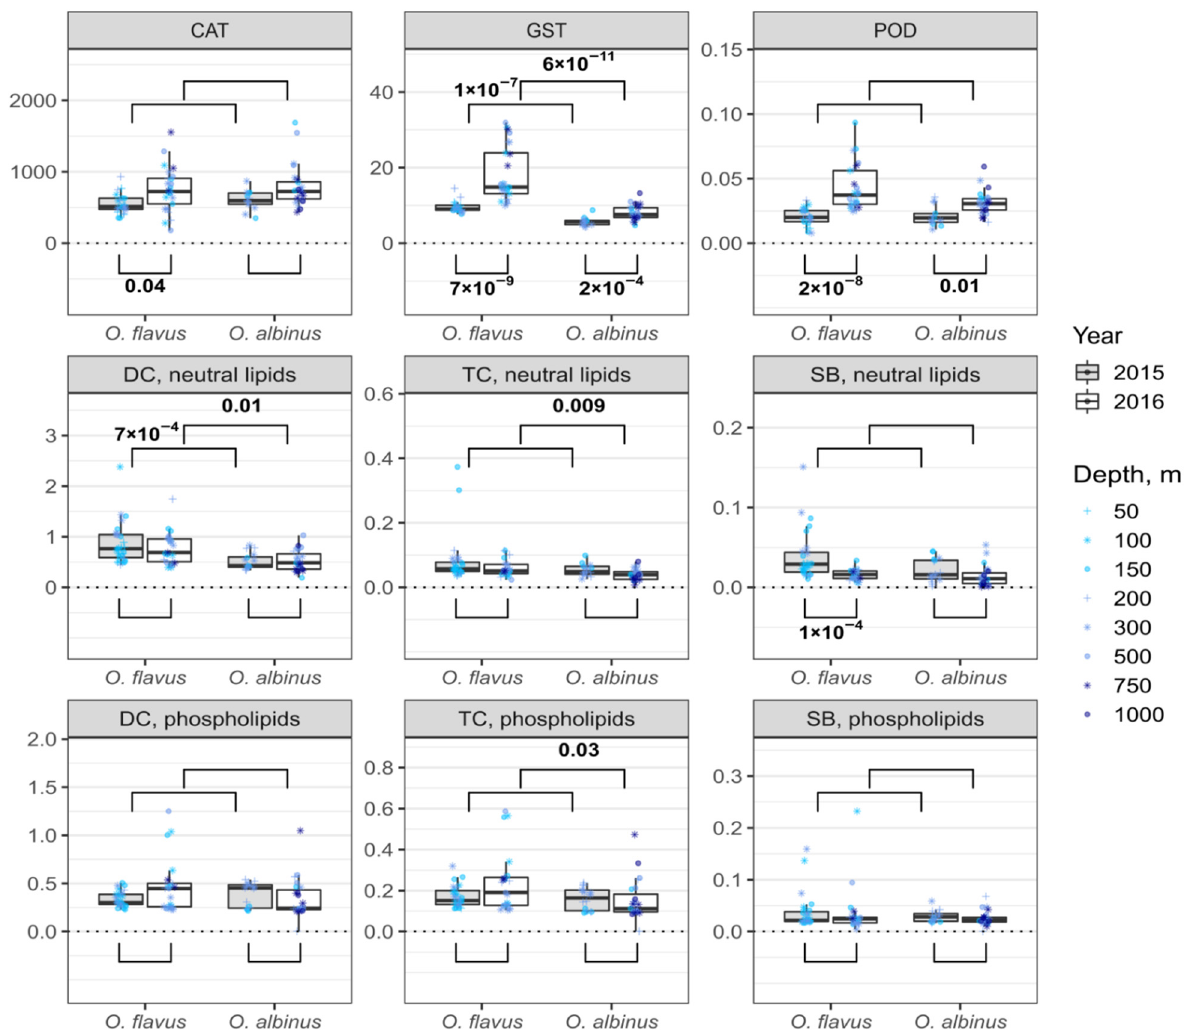
Figure 3. Biochemical parameters related to oxidative status in O. flavus and O. albinus fixed right after collection from deep-water traps. Measurements for amphipods from all depths were pooled within each sampling year; n = 27–30 for O. flavus and n = 21–26 for O. albinus . Values are expressed as nkat mg − 1 of protein for the enzyme activities (CAT, GST, POD) and in a.u. for lipid peroxidation products (DC, TC and SB). The numbers near the brackets indicate p -values for respective pairwise comparisons if the difference is statistically significant (Mann–Whitney U-test with Holm’s correction for multiple comparisons). A similar comparison that only includes the samples from 100–300 m is presented in Figure S3.